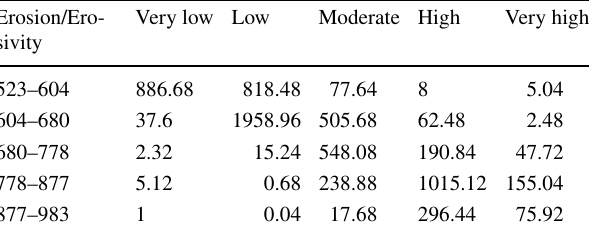
Table 11 Relationship between soil erosion and erosivity Erosion/Ero- sivity